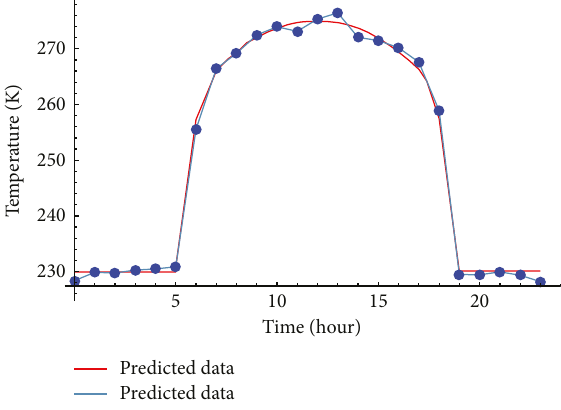
Figure 5: The comparison of the temperature of the fi lm.